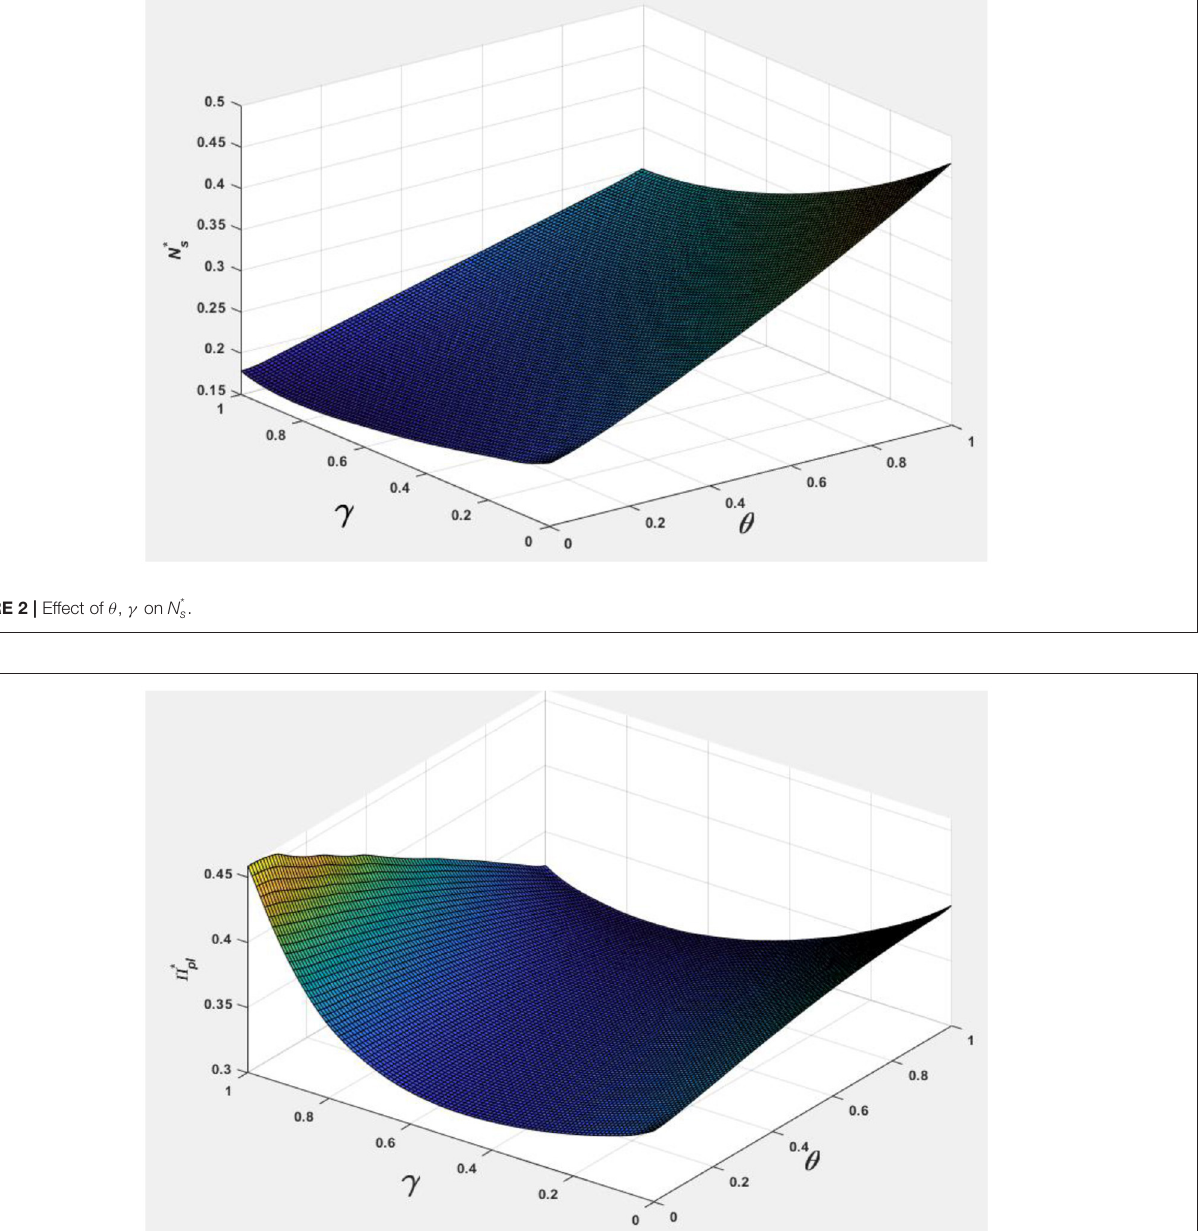
FIGURE 3 | Effect of θ , γ on 5 * pl